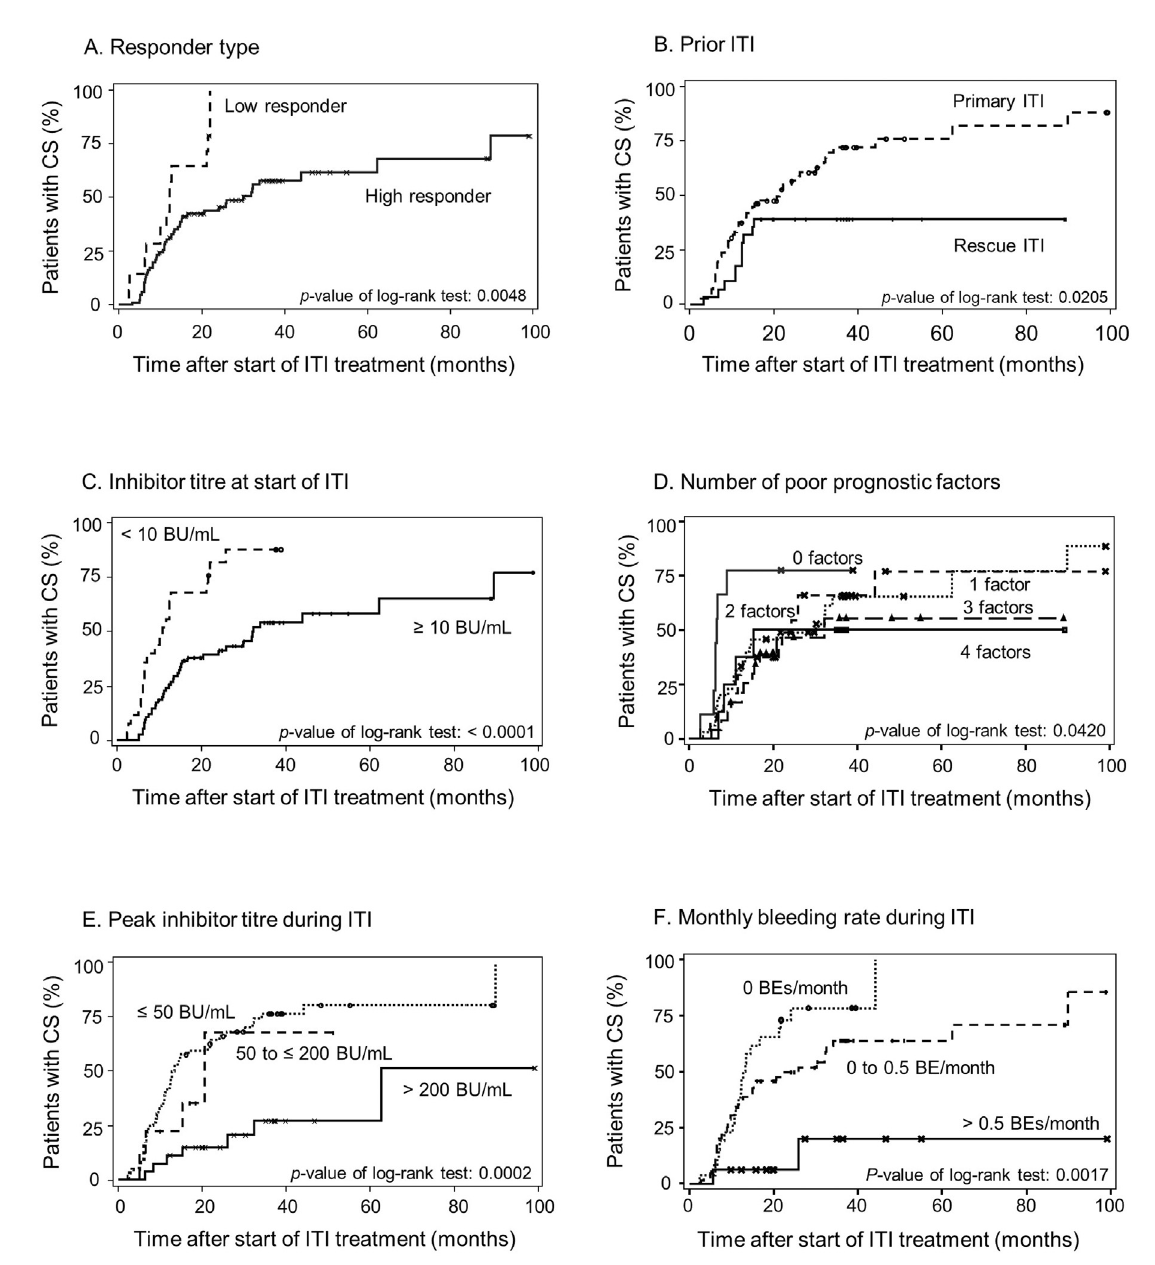
Fig. 3 Poor prognosis factors associated with time to achievement of complete success (CS) in the overall immune tolerance induction (ITI) population ( n ¼ 100). Kaplan – Meier curves showing the time-to-achievement of ITI success in relation to key variables shown to be signi fi cant in this study: ( A ) responder group (low vs. high p ¼ 0.0048); ( B ) prior ITI (primary vs. rescue, p ¼ 0.0205); ( C ) inhibitor titer at ITI start ( < 10 BU/mL vs. (cid:1) 10 BU/mL, p < 0.0001); ( D ) number of poor prognostic factors ( p ¼ 0.0420); ( E ) peak inhibitor titer during ITI ( p ¼ 0.002); ( F ) monthly bleeding rate during ITI ( p ¼